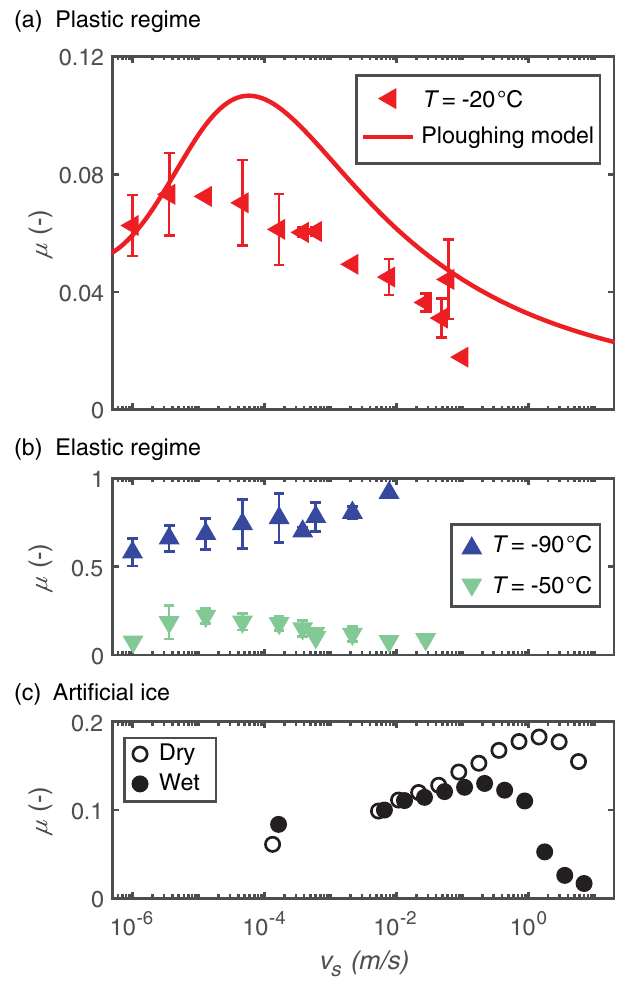
FIG. 5. Friction coefficient μ as a function of the sliding speed v s for a smooth glass sphere (surface roughness S q ¼ 98 nm). All measurements were performed with increasing and decreasing sliding velocity to confirm that hysteresis was absent. (a) At − 20 °C (red triangles), a nonmonotonic dependence of the friction on the sliding speed is found, which can be understood based on ploughing [Eq. (6), red line]. (b) At − 50 °C (green triangles) and − 90 °C (blue triangles), velocity strengthening of the friction is observed, which can be qualitatively described as a result of a stress-augmented thermal process; the stress exerted by the slider at the interface decreases the effective activation barrier, resulting in a logarithmic increase of the stress with the rate or velocity. friction on artificial ice (HDPE) (using the same glass slider) at room temperature and at a normal force of 1 N. The error bars represent the standard deviation in the measured friction force. In panel (c), the error is of the order of the symbol